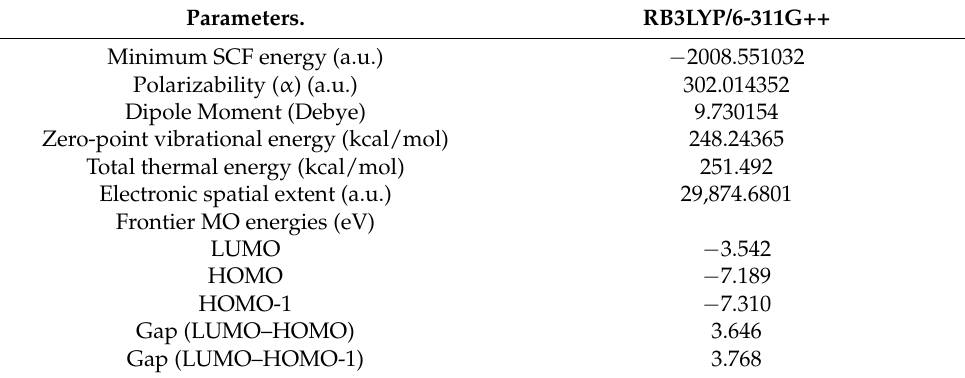
Table 3. Theoretical molecular characteristics and components of CT complex [(FXN)(PA)].